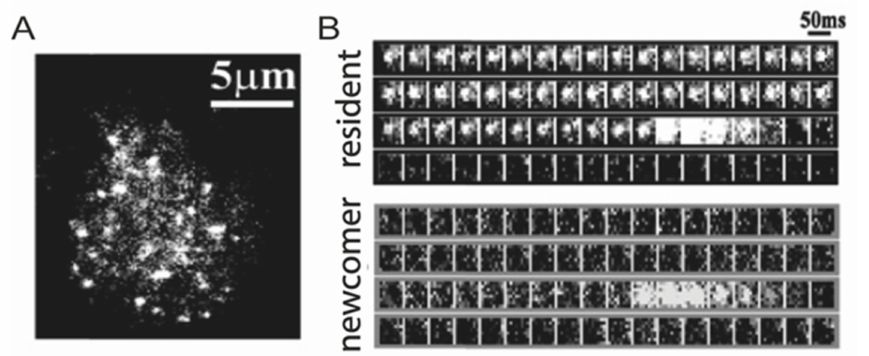
Figure 7. Exocytosis of ISGs studied by TIRF microscopy. ( A ) Example of TIRF image of GFP-labeled insulin granules in a rat primary β -cell. Scale bar: 5 µ m). ( B ) Sequential images (1 µ m × 1 µ m per 50-ms interval) of a granule docking and fusing with the plasma membrane were presented during 22 mM glucose stimulation. Adapted from Ohara-Imaizumi et al.